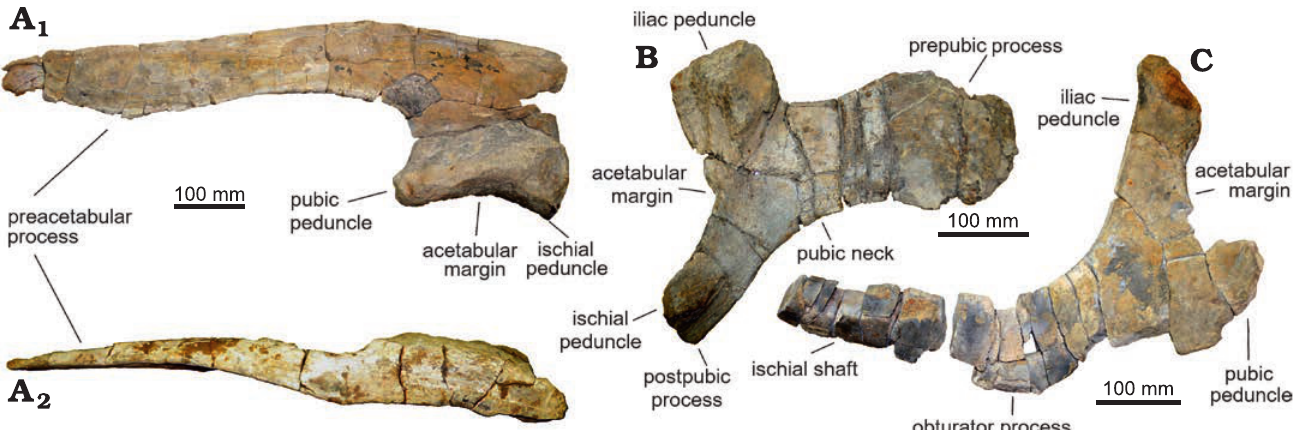
3. Lambeosaurinae indet., pelvic gridle elements of FCBUANL_2711, from Ejido Presa San Antonio, Coahuila, Mexico, upper Campanian. A . Left ilium in lateral (A 1 ) and dorsal (A 2 ) views. B . Right pubis in lateral view. C . Right ischium in lateral